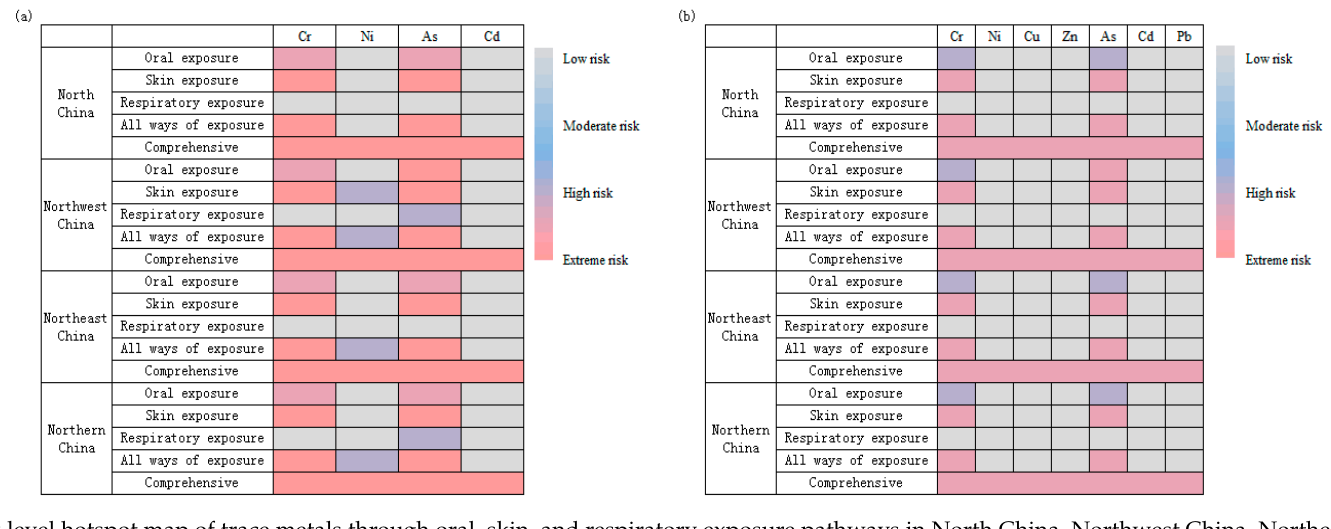
Figure 4. Risk level hotspot map of trace metals through oral, skin, and respiratory exposure pathways in North China, Northwest China, Northeast China, and northern China. ( a ) Carcinogenic risk level hotspot map of Cr, Ni, As, and Cd. ( b ) Human health risk level hotspot map of Cr, Ni, Cu, Zn, As, Cd, and Pb. Color description: orange-red represents extreme risk, purple-red represents high risk, purple-blue represents moderate risk, and gray represents low risk.